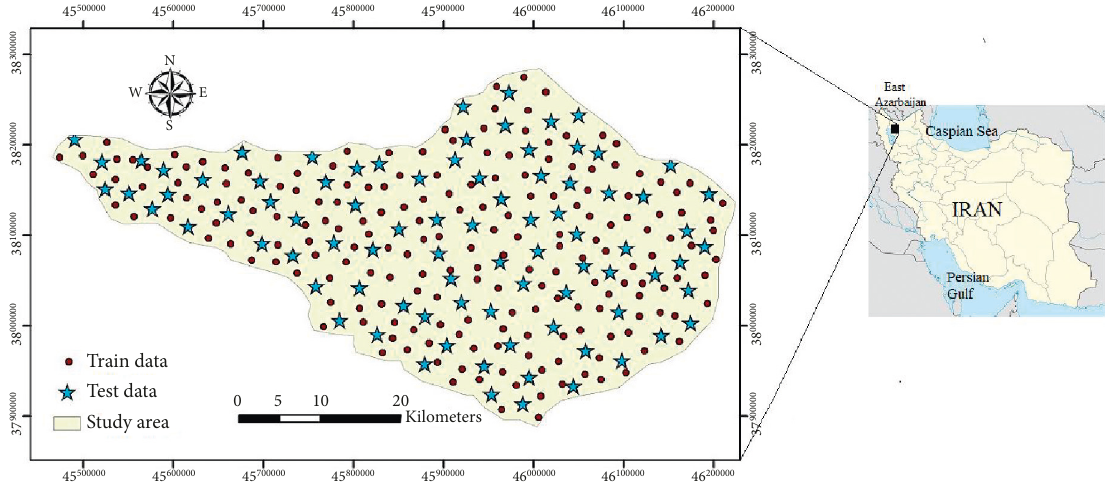
Figure 5: Location of the study area along with sampling points. Table 1: Descriptive statistics of CEC and the soil parameters at the sampling points (training ( n � 195) and testing ( n � 85)). Data set